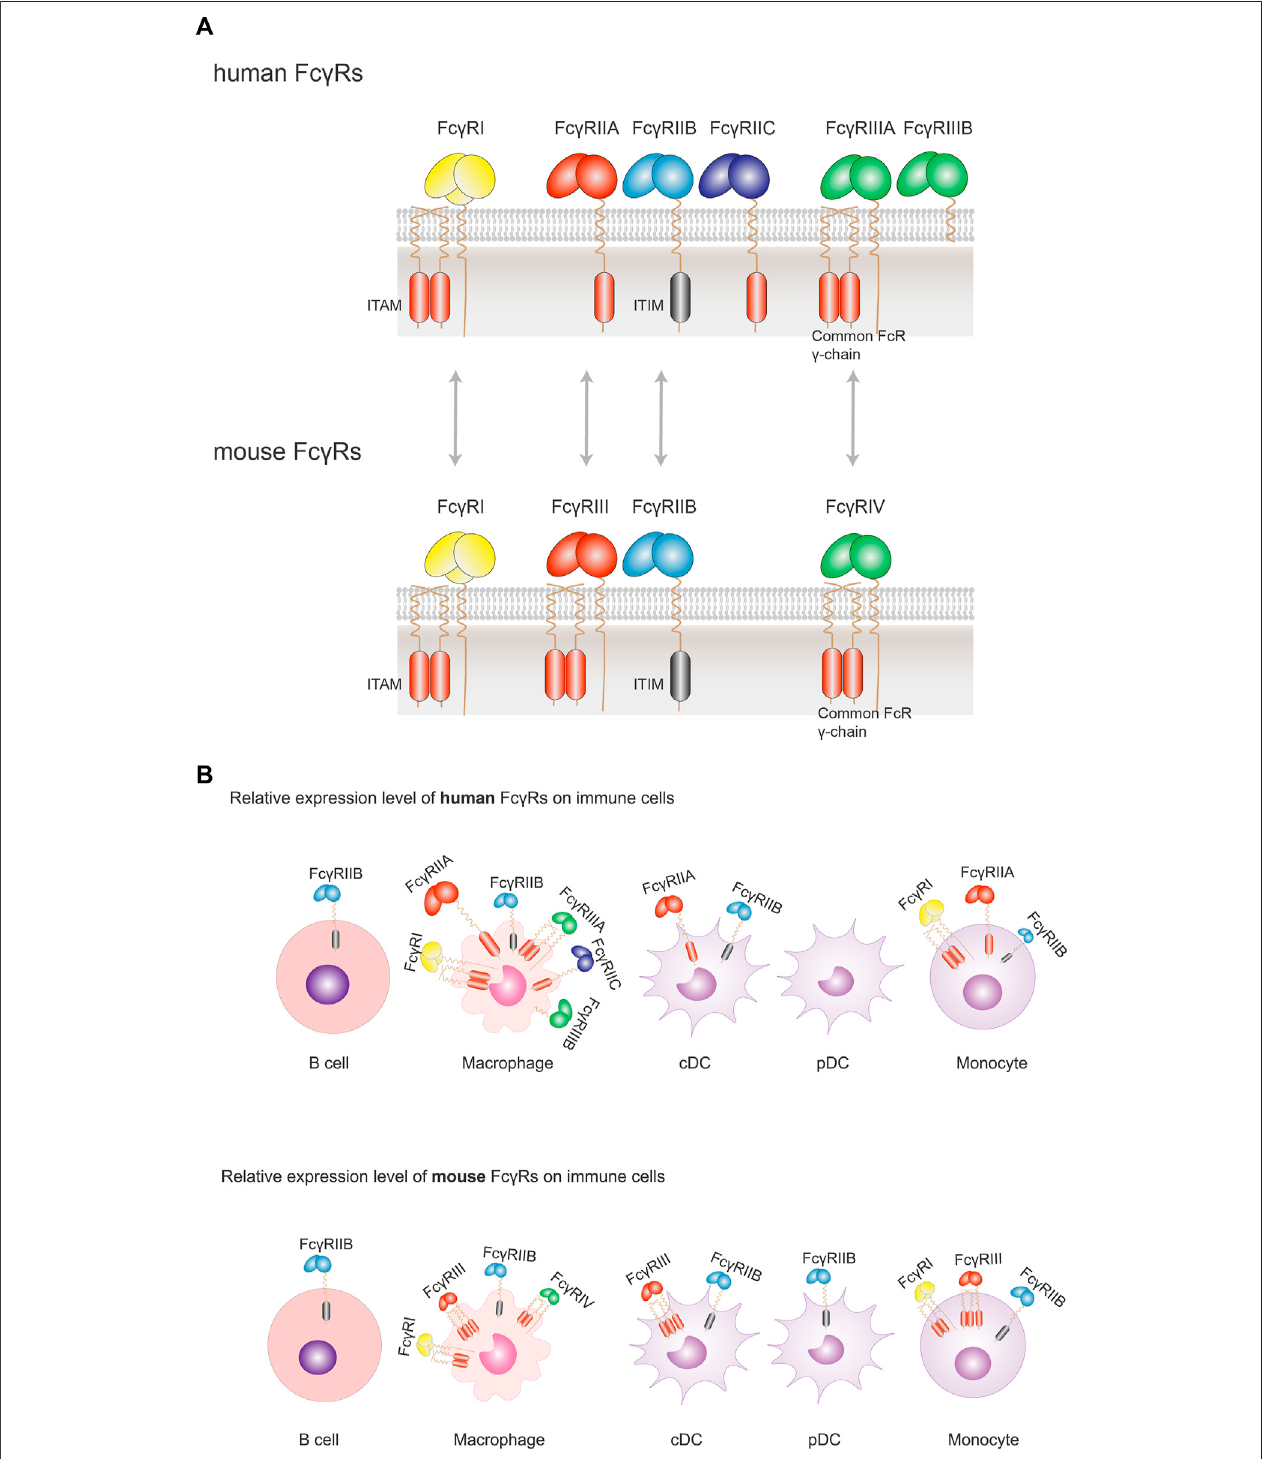
FIGURE3| OrthologouspairsofFc γ Rsbetweenhumanandmouseandtheircellularexpression. (A) Inhuman,threegroupsofFc γ Rshavebeendescribed:Fc γ RI, Fc γ RIIA/B/C, Fc γ RIIIA/B. Orthologous pairs identi fi ed in mouse include human Fc γ RIand mouse Fc γ RI, human Fc γ RIIA and mouse Fc γ RIII, human Fc γ RIIB and Mouse Fc γ RIIB, and human Fc γ RIIIA and mouse Fc γ RIV. All activating Fc γ Rs, except Fc γ RIIIB, are associated with an immunoreceptor tyrosine-based activation motif (ITAM) either in the intracellular domain (Fc γ RIIA and Fc γ RIIC) or associated with the common FcR γ chain (Fc γ RI and Fc γ RIIIA). There is only one inhibitory Fc γ R (Fc γ RIIB) in human or mouse. Fc γ RIIB contains an immunoreceptor tyrosine-based inhibitory motif (ITIM) in the intracellular domain. (B) Fc γ Rs are expressed solely or